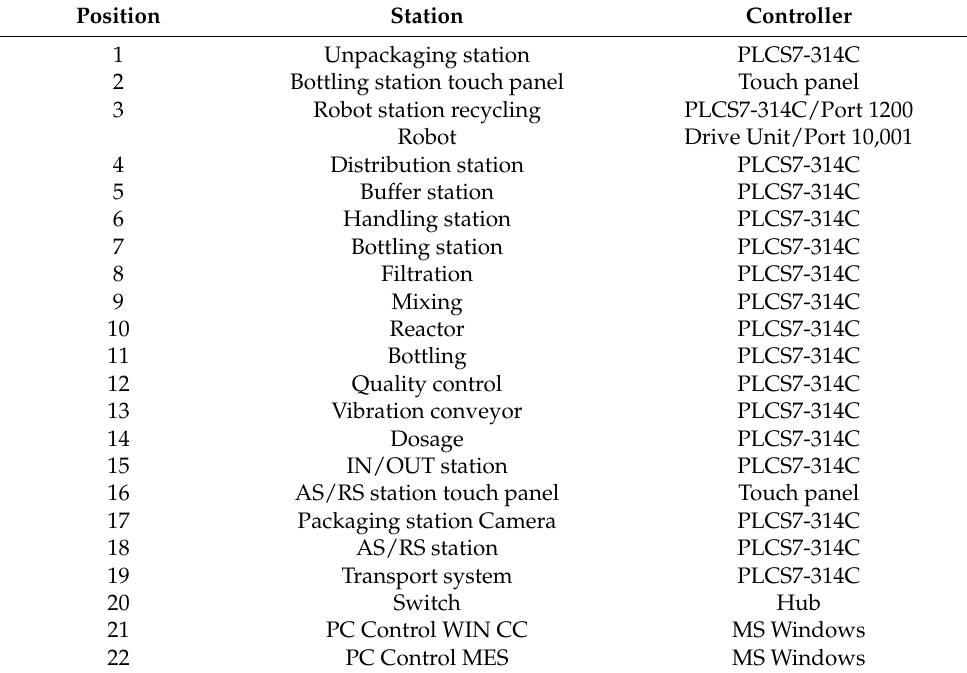
Figure 3. Functional overview of production line. Table 2. Parts of the production line.